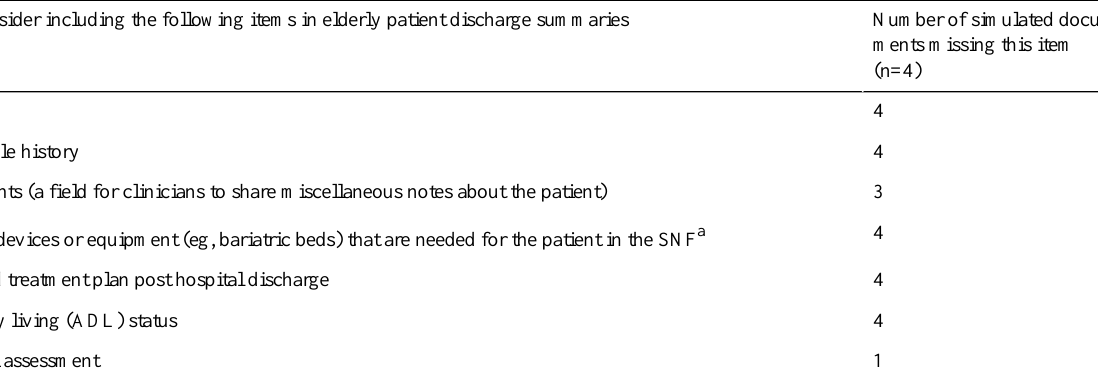
Table 3. Second new guideline, with the list of items that should be considered to be included in elderly patient discharge summaries and how many of the 4 simulated discharge summaries were missing each item.